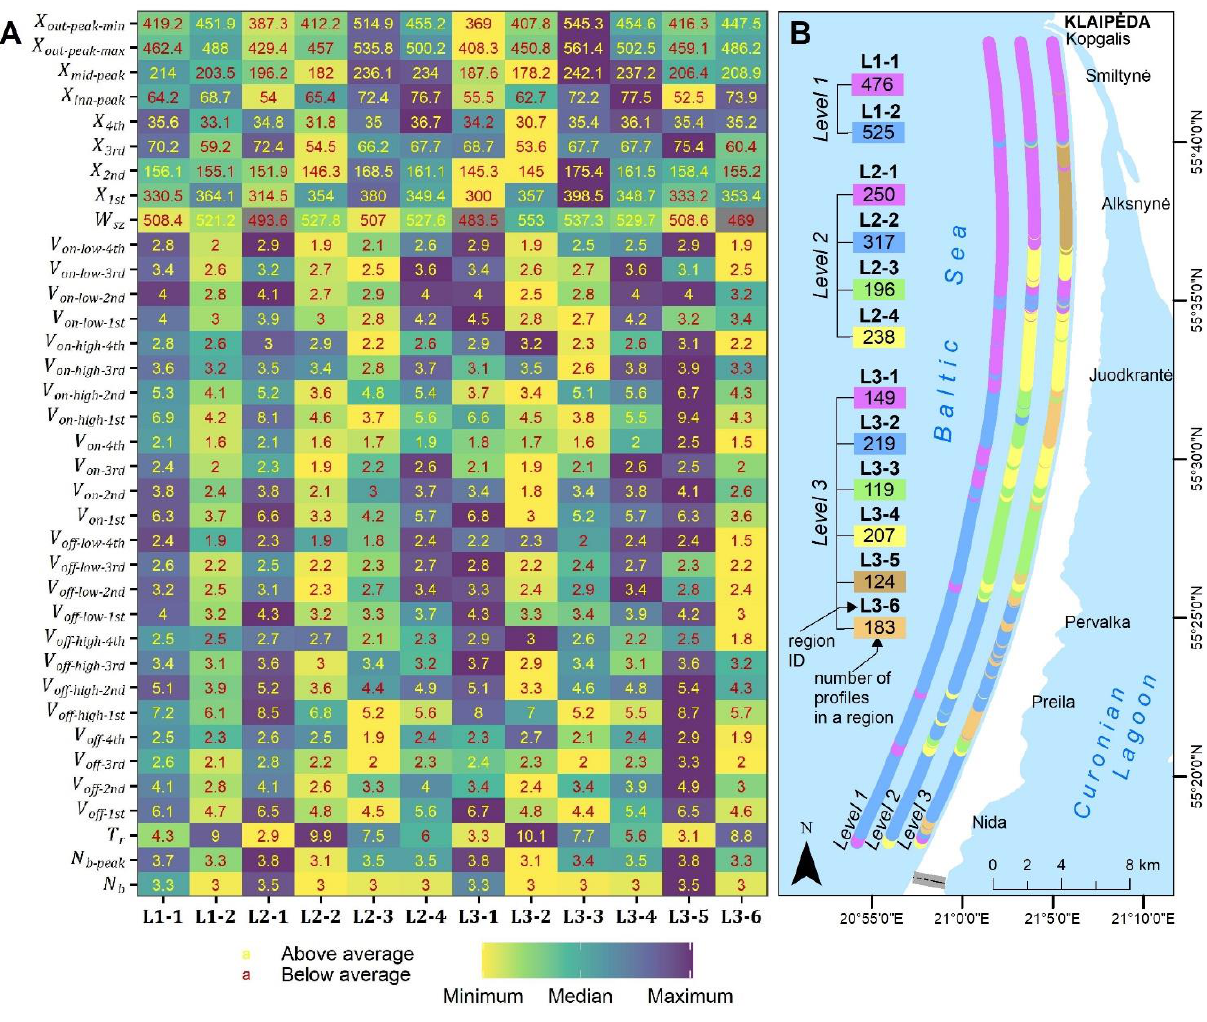
Figure 11. Large- (Level 1, L1), middle- (Level 2, L2), and small (Level 3, L3)-scale nearshore bar behaviour (NBB) regions in the Curonian Spit: ( A ) mean temporal and morphological bar characteristics in NBB regions; ( B ) location of the NBB regions.